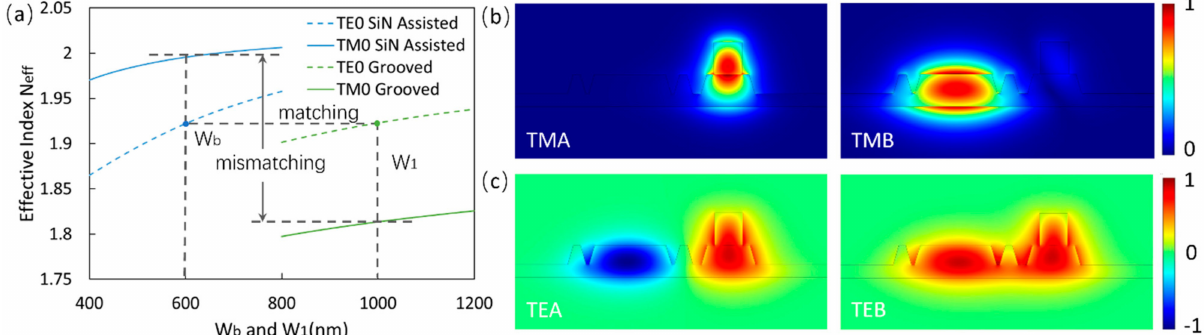
Figure 3. ( a ) Calculated effective index of TE 0 and TM 0 modes in Si3N4 assisted LN WGs and grooved LN WGs as a function of WG width. Electrical field profiles of ( b ) two quasi-TM super-modes, and of ( c ) odd and even TE super-modes in the coupling